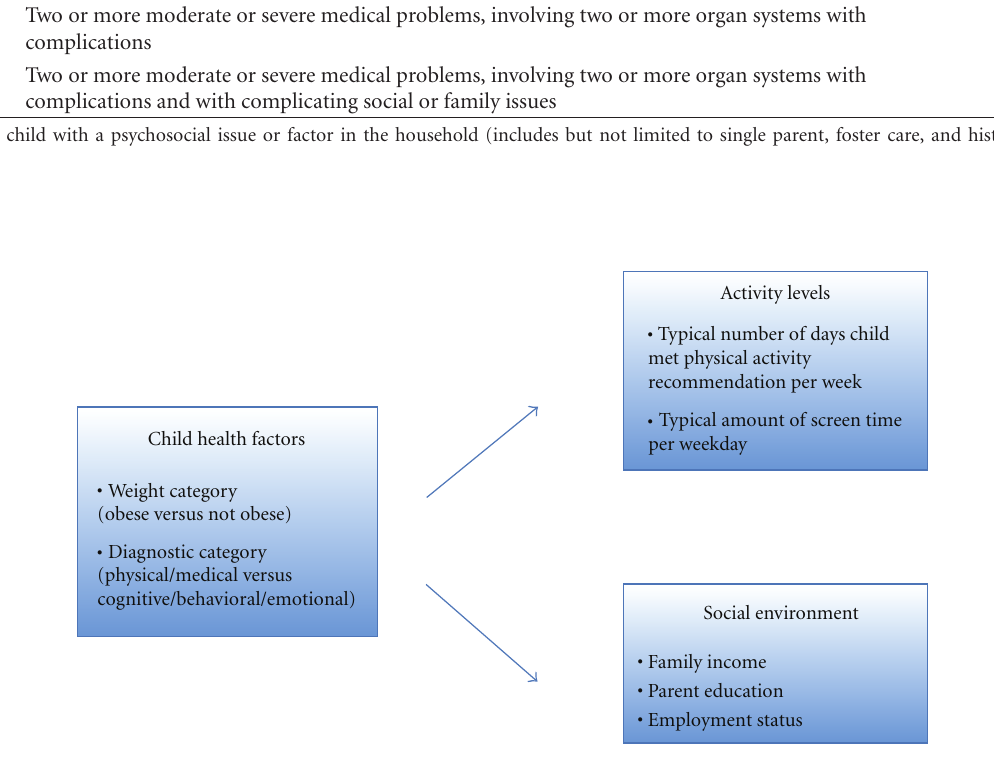
Figure 2: Items explored in correlation